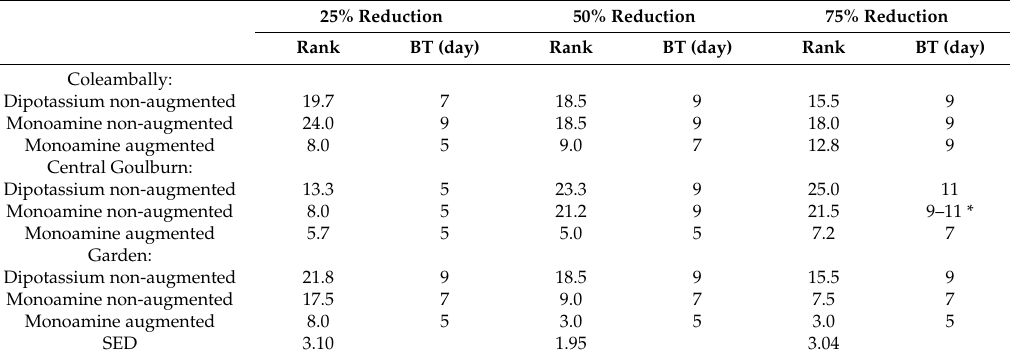
Table 9. Effect of treatments on the first day in which endothall isomer-1 concentration was observed to decay by 25, 50 or 75% of its total decay. Analysis only includes mesocosms treated with sediment. Days are transformed to ranks with ties. BT = Back transformed. SED = Standard error of the